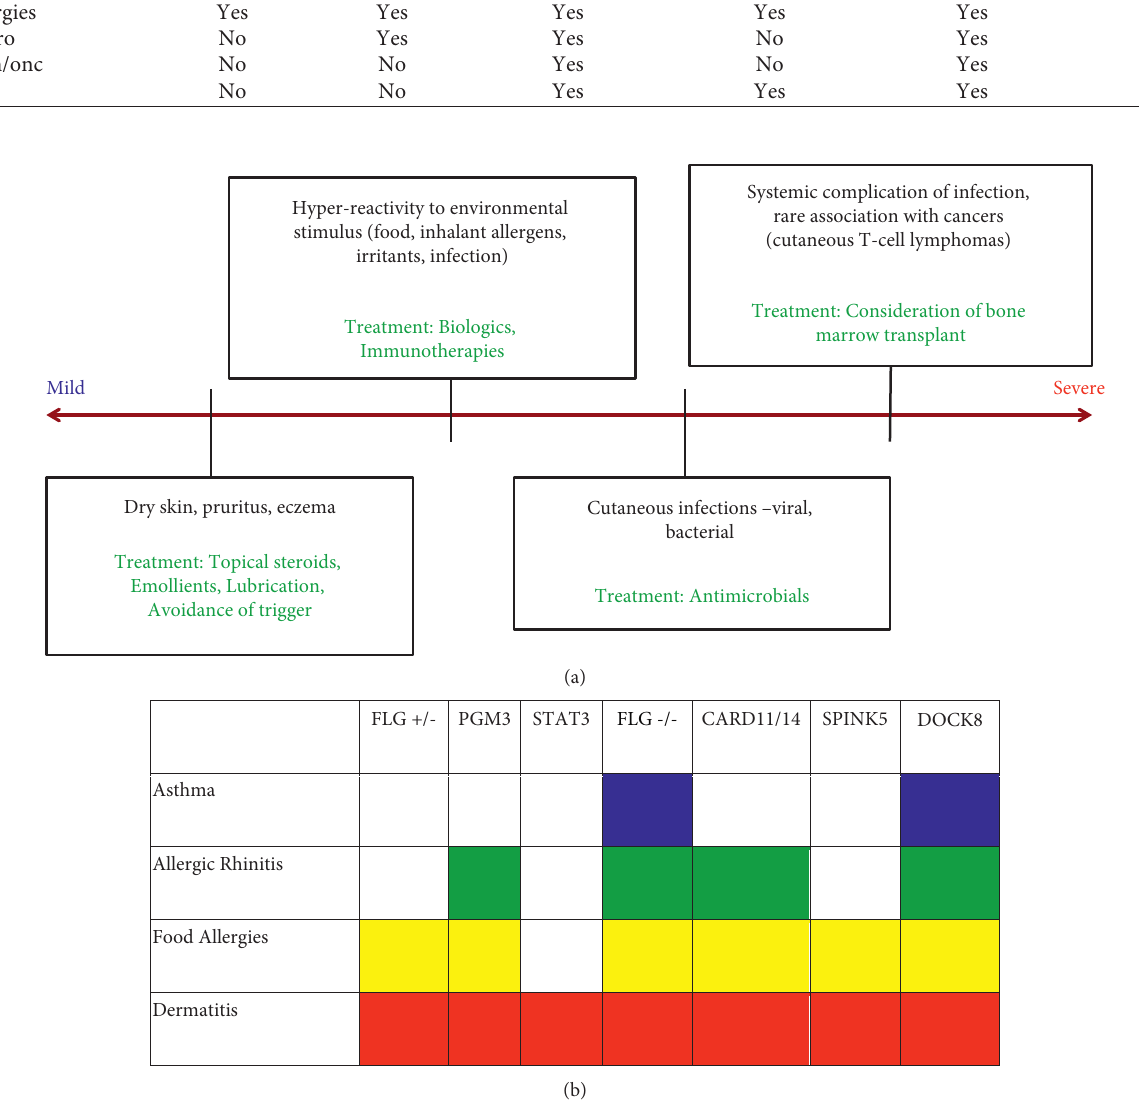
Figure 1: (a) Spectrum of disease in patients with elevated IgE. (b) Genetically defined markedly elevated IgE.